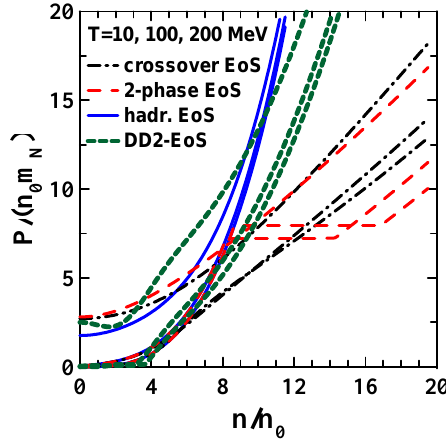
Figure 1. Pressure scaled by the product of normal nuclear density ( n 0 = 0.15 fm − 3 ) and nucleon mass ( m N ) versus baryon density (scaled by n 0 ) for three EoSs used in the simulations and also for the DD2 EoS [34] that is compatible with astrophysical constraints. Results are presented for three different temperatures T = 10, 100 and 200 MeV (bottom-up for corresponding